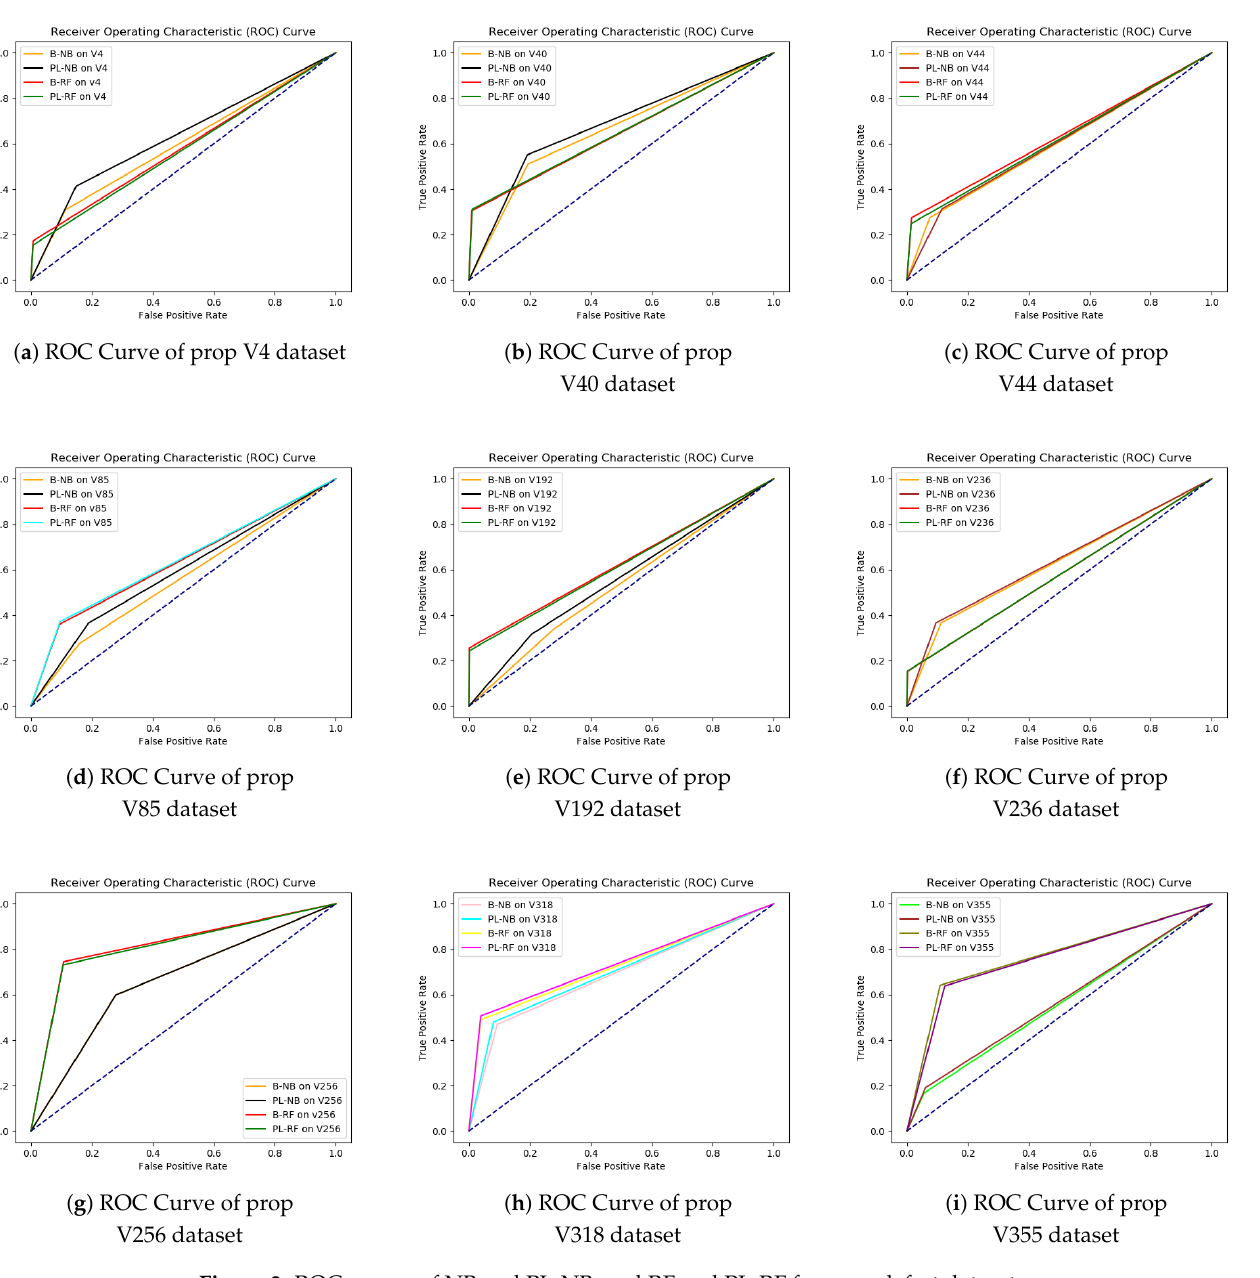
Figure 3. ROC curves of NB and PL-NB, and RF and PL-RF for prop defect